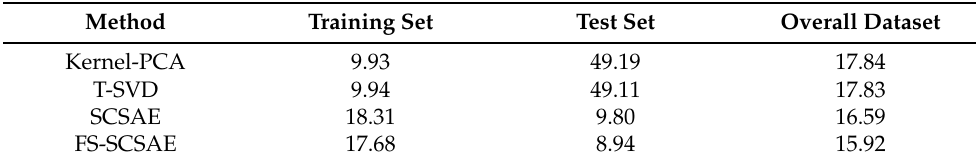
Table 8. Evaluation of reconstruction errors (MAEs) of the comparative methods.